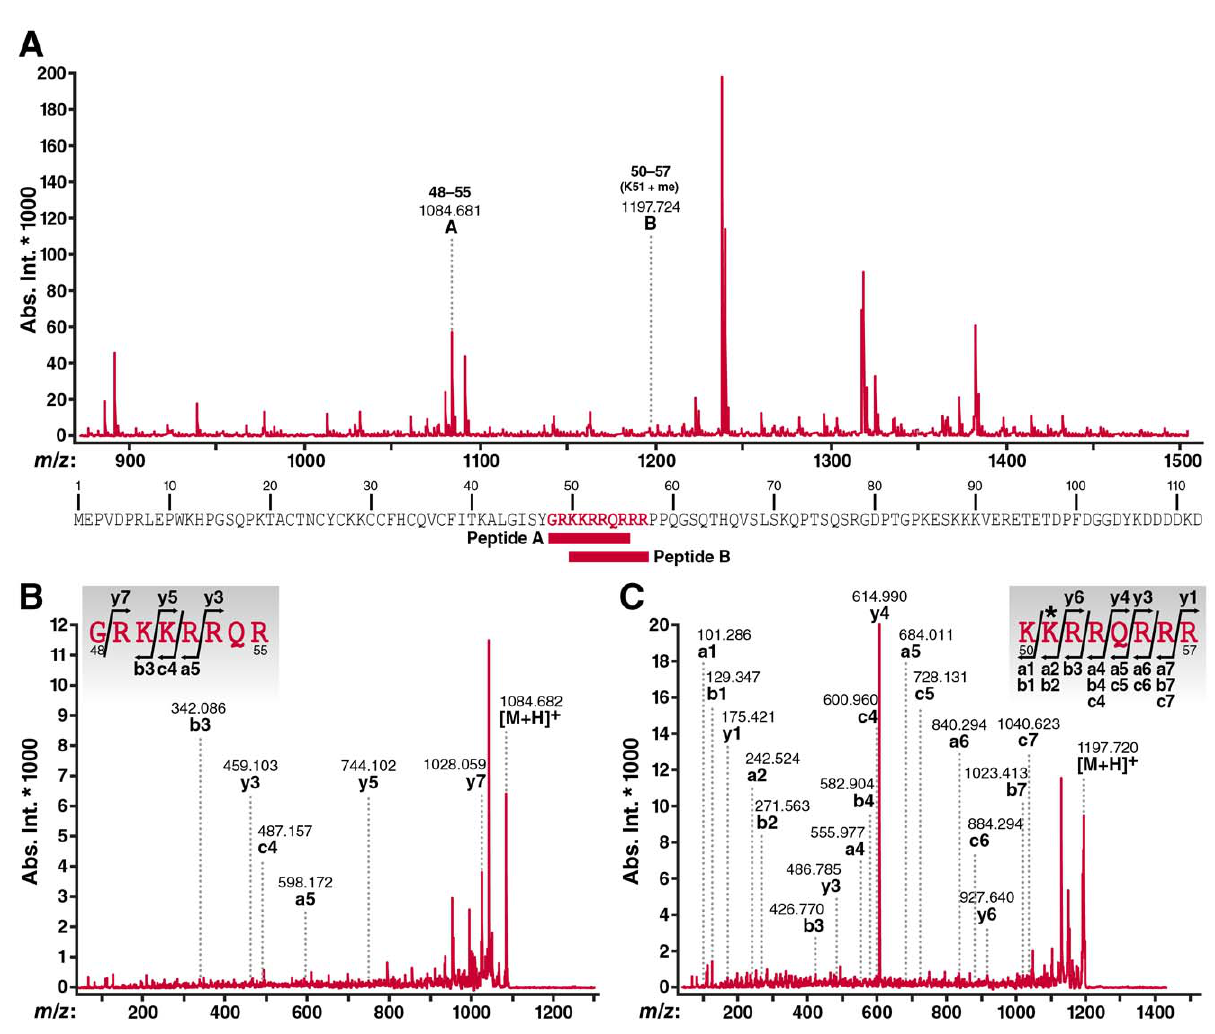
Figure 2. MALDI-TOF mass spectrometric analysis of cellular Tat confirms K51 monomethylation. (A) MALDI-TOF MS spectrum of digested peptides from Tat-FLAG (900-1,500 m/z ) immunoprecipitated from J-Lat A2 cells activated with TNF a . The peptide ions (designated as A and B) further analyzed by MS/MS are indicated by m/z values and number of amino acid sequence. Their position within the Tat-FLAG molecule used in this study is indicated below. Please note that studies were performed with chymotrypsin to avoid restraints in trypsin-based cutting caused by modifications of lysines. However, some identified ARM peptides are shorter than anticipated based on the predicted size of chymotrypsin-digested peptides in Tat which is likely due to a contamination with some trypsin-like activity in the chymotrypsin preparations used in this experiment. (B) MALDI-TOF/TOF MS/MS spectra of peptide A ion (1084.681 m/z ). (C) MALDI-TOF/TOF MS/MS spectra of peptide B ion (1197.724 m/z ). In these spectra, identified fragment ions were denoted by the ion types, a, b, c, y according to the nomenclature by Roepstorff and Fohlman [57]. The assignment of fragment ions to the amino acid sequence of the ARM region of the Tat molecule was inserted in each spectrum. The symbol * indicates methylated amino acid